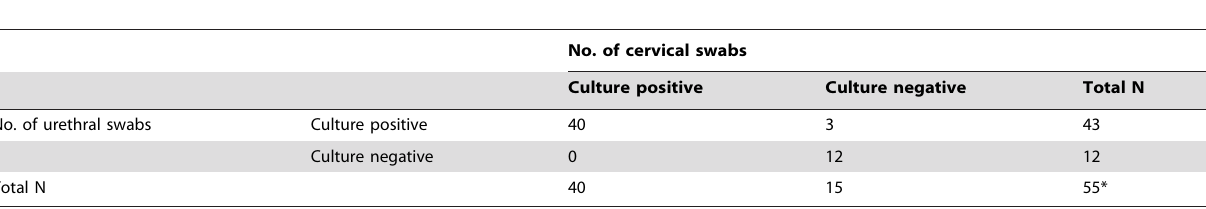
Table 4. Distribution of ureaplasma positive and negative samples in 55 paired urethral and cervical swabs collected from the same woman as determined by culture.